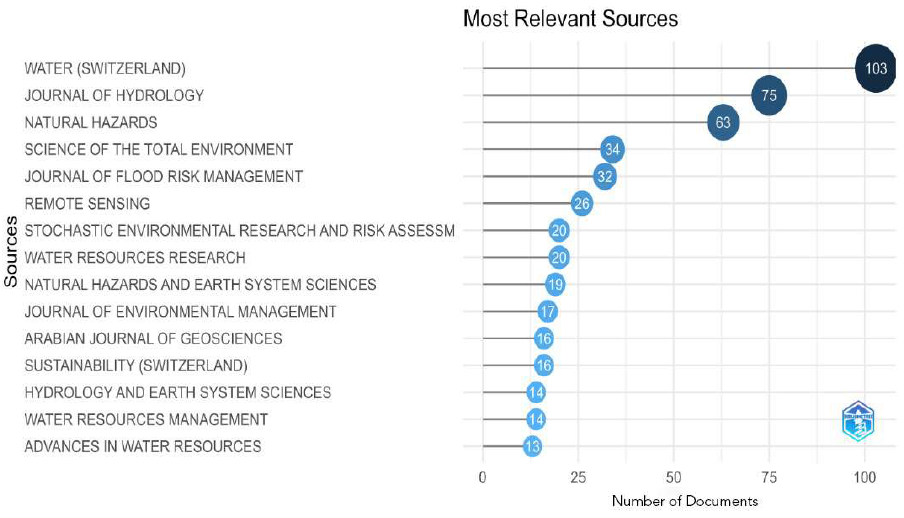
Figure 4. Most Relevant